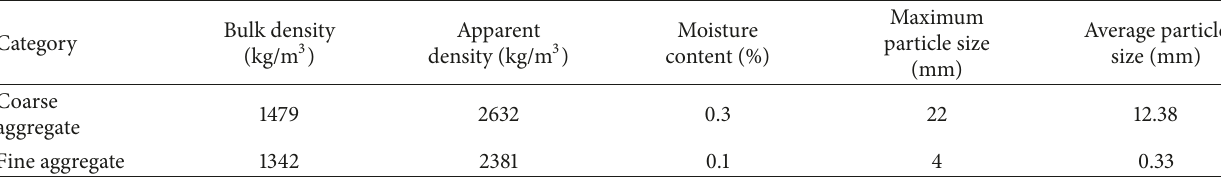
Table 1: Properties of aggregates.